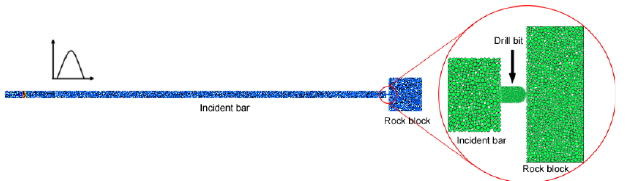
Fig. 1. Numerical dynamic indentation model in 2D PFC.